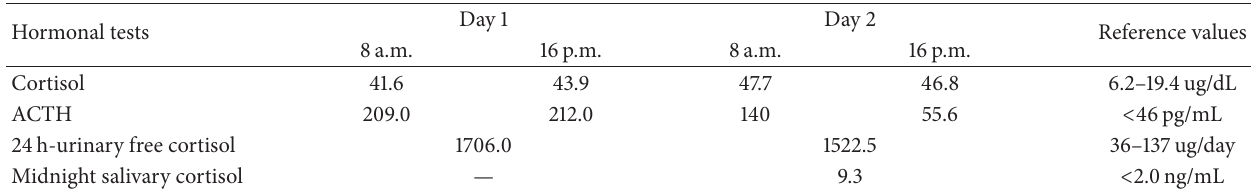
Table 1: Hormonal tests.